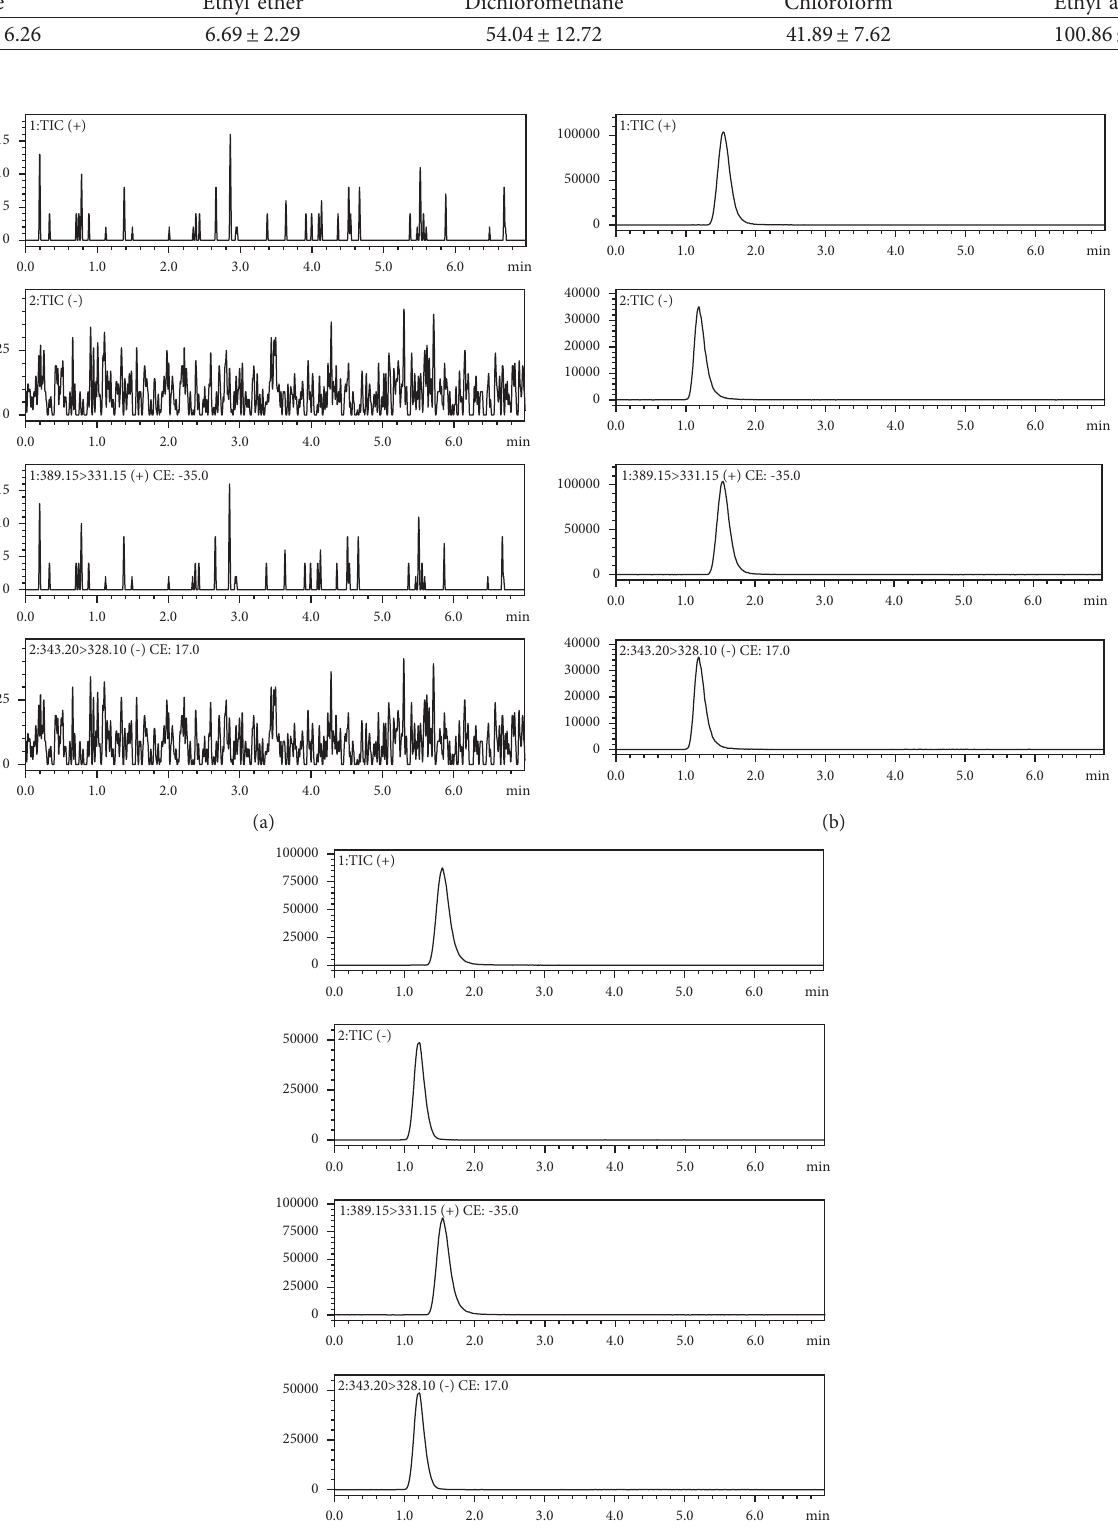
Figure 5: The MRM chromatograms of blank plasma (a), blank plasma with 5ng/mL TMEA and 50ng/mL IS (b), and plasma collected at 0.5h after treated with 4mg/kg TMEA in thrombocytopenia rat and 50ng/mL IS